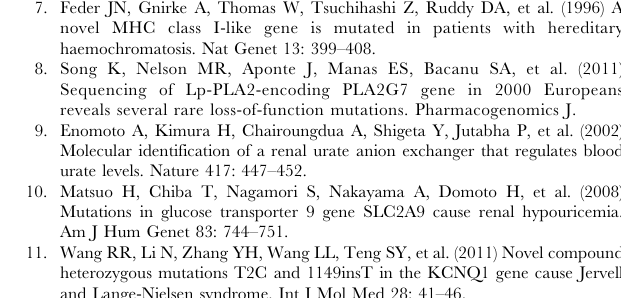
Figure S1 The LD r2 distribution of the physically close and rare SNP pairs on Illumina 550K chip.